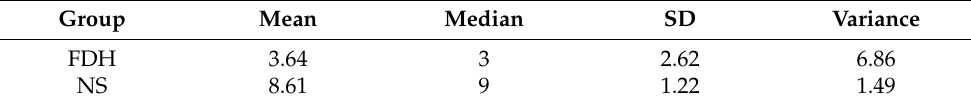
Table 5. Descriptive statistics obtained from the foreign accent rating task for both the FDH and the NS groups.